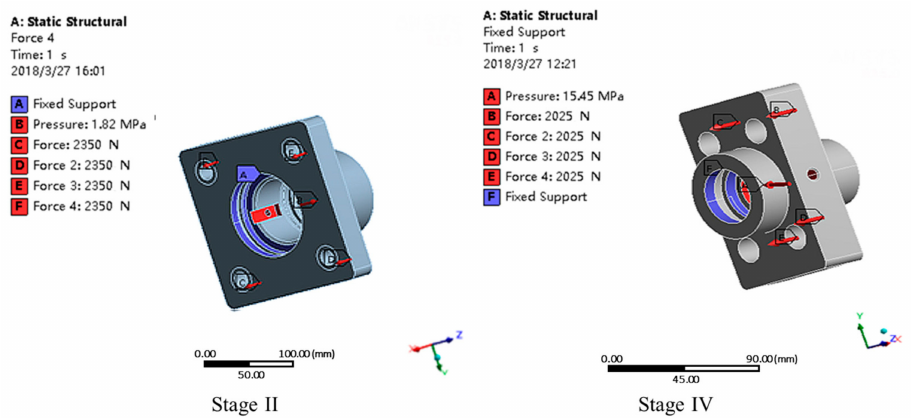
Figure 6. Boundary conditions of the stress analysis for the end